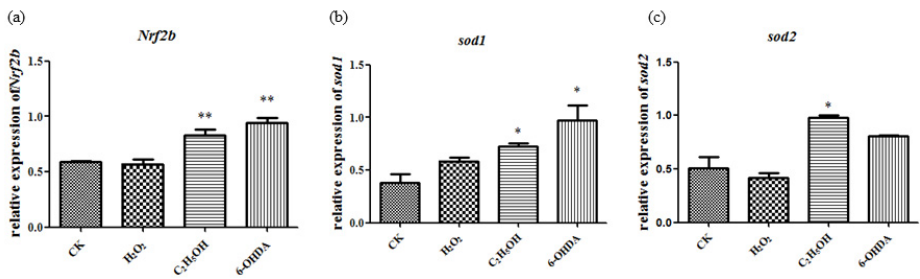
Figure 6. Ethanol, H 2 O 2 and 6-OHDA promote the expression of myl2a ( a ), selenbp1 ( b ) and ca2 ( c ). The statistical results shown represent the means ( n = 3); vs. the control group ( n = 3) * p < 0.05, ** p < 0.01.